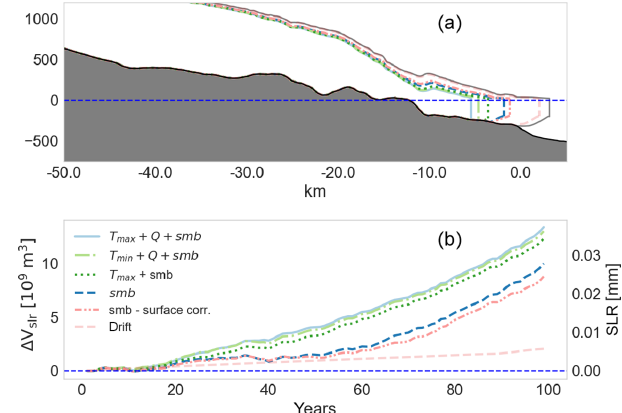
Figure 10. (a) Yngvar Nielsen Glacier with a representative medium-SLR retreat scenario applying forcing factors as subglacial discharge Q , ocean temperature T , and surface mass balance SMB with and without accounting for surface elevation correction (SMB − surface corr.) for the medium-SLR scenario. The corresponding SLR of each experiment is displayed in panel (b)